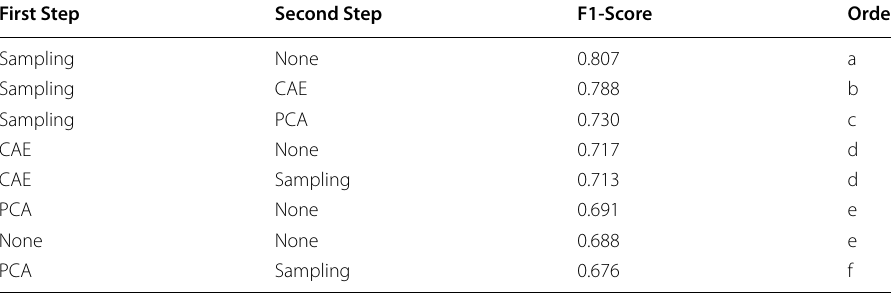
Table 12 Tukey’s HSD Results for F1 Score: Scenario Factor